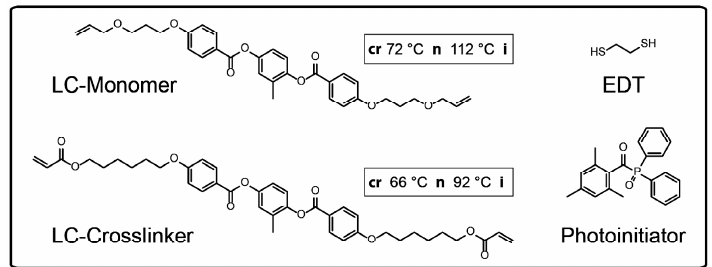
Figure 2. Chemical structures of the components which were used in the liquid crystalline monomer mixture. The phase transition temperatures of the mesogenic LC-monomer and LC-crosslinker were measured via differential scanning calorimetry. (EDT: 1,2-ethanedithiol).